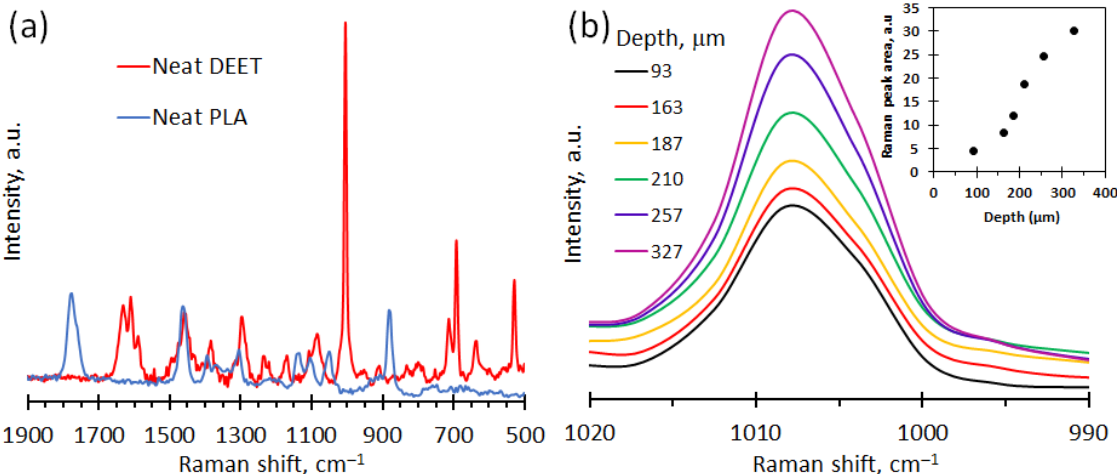
Figure 4. Raman spectra of: ( a ) Spectrum for neat DEET and neat PLA. ( b ) Confocal Raman spectra recorded at different positions inside a PLA strand initially containing 15 wt.% DEET. The distance from the surface indicated in units of µm. The insert shows integrated peak areas for the Raman band located between 1000 and 1020 cm − 1 as a proxy for the concentration of DEET inside the PLA strand.